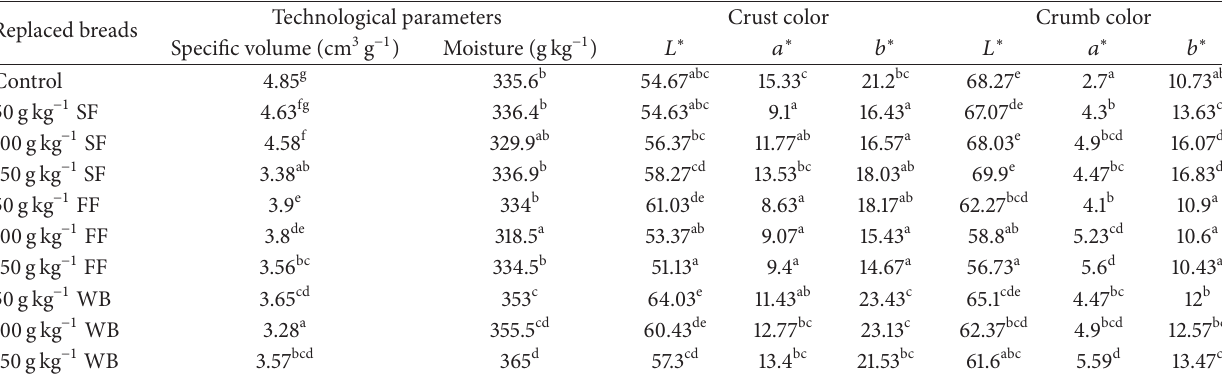
Table 4: Technological and color parameters of breads replaced with 50, 100, and 150 gkg −1 of functional flours a . Technological Replaced breads